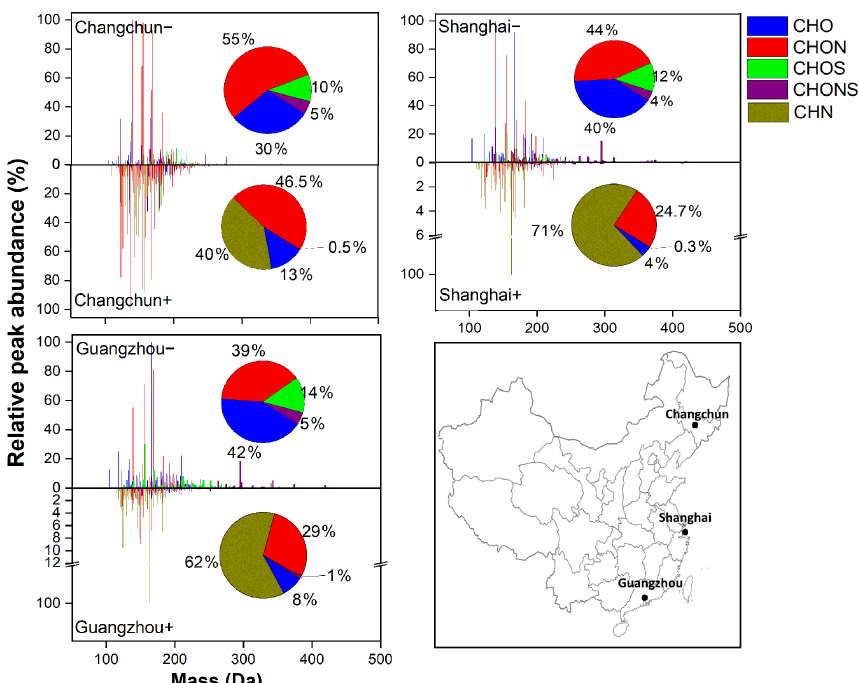
Figure 1. Mass spectra of detected organic compounds reconstructed from extracted ion chromatograms in ESI- and ESI+. The horizontal axis refers to the molecular mass (Da) of the identified species. The vertical axis refers to the relative peak abundance of each individual compound compared to the compound with the greatest peak abundance. The pie charts show the percentage of each organic compound subgroup (i.e., CHO, CHON, CHOS, CHONS and CHN) in each sample in terms of peak abundance. The map in the lower right corner shows the locations of these three megacities in